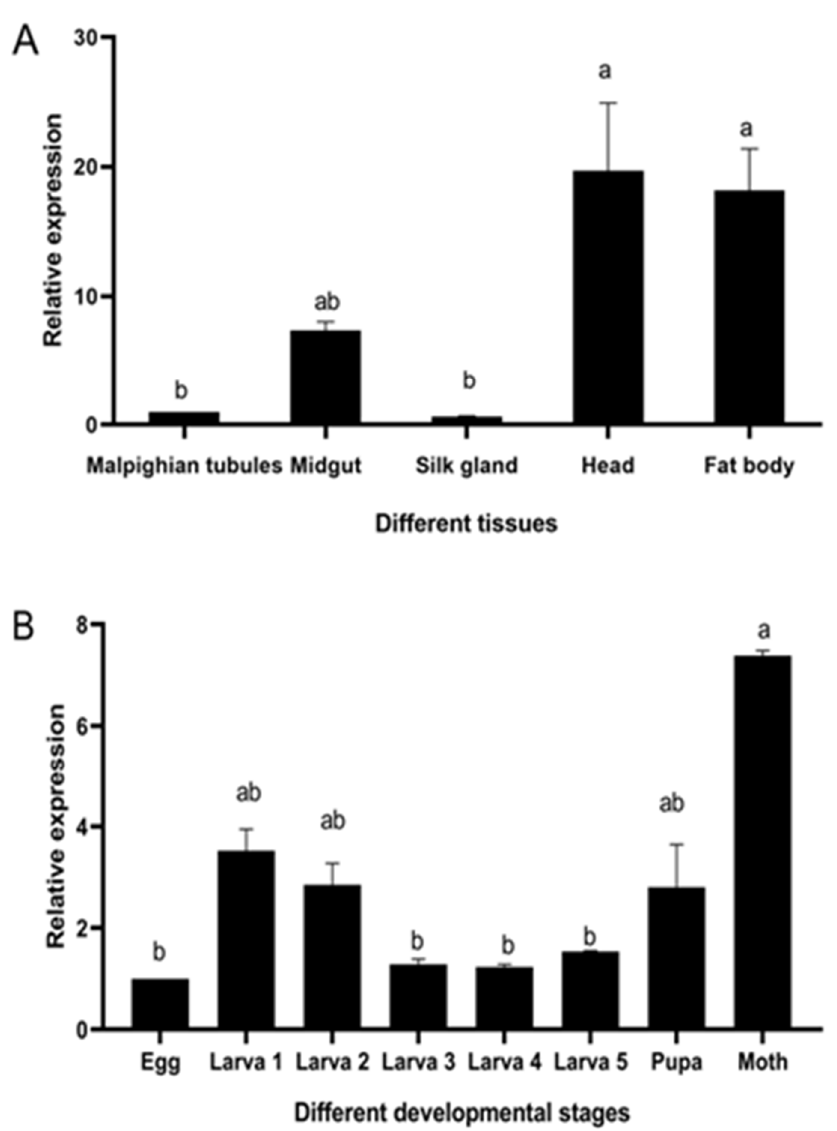
Figure 4. Relative mRNA level of the BmUGT46A1 gene in different tissues and different develop- mental stages. ( A ) Relative mRNA levels in the head, midgut, fat body, Malpighian tubules, and silk gland. The relative expression of UGT46A1 in the Malpighian tubules group (quantity was 1) was the control group. ( B ) The relative mRNA levels of UGT46A1 in whole silkworms at different developmental stages. The relative expression of UGT46A1 in the egg group (quantity was 1) was the control group. The expression levels were examined using quantitative real-time PCR. The gene actin A3 was used as the internal control. The data shown were the mean ± SD (n = 3). Different letters indicate statistical differences. The same letters in the figure indicate that the difference was not significant; different letters indicate that the difference was significant (ANOVA, Tukey test, P < 0.05).